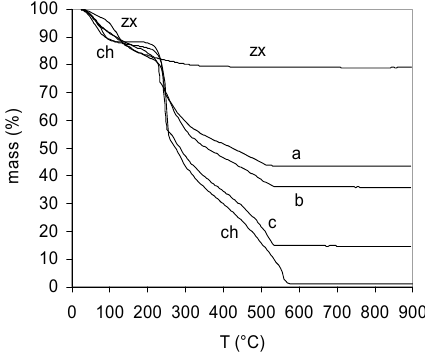
Figure 2. TG plots of aerogels of chitosan ( ch ), composites A ( a ); B ( b ); C ( c ) and zeolite X ( zx ).